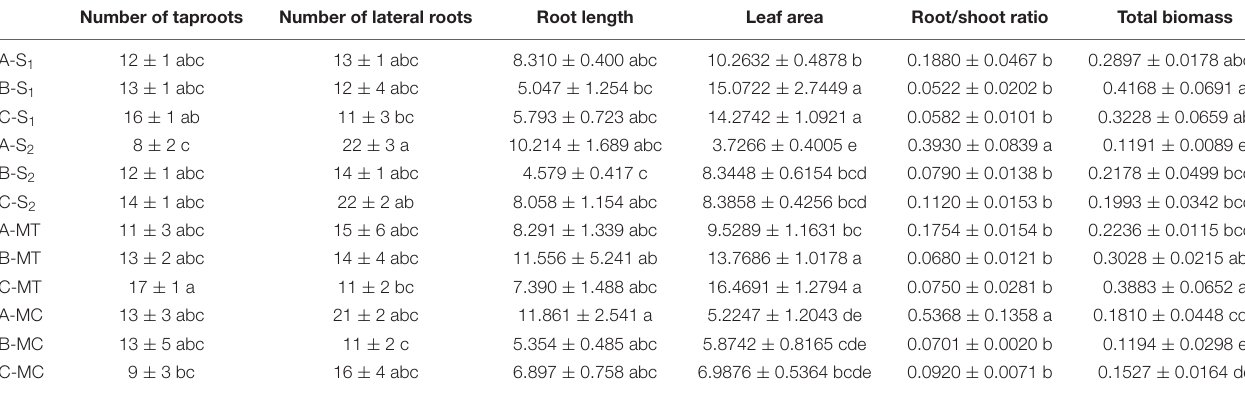
TABLE 2 | Effect of different nitrogen forms and competitive treatments on plant growth under high nitrogen condition. Number of taproots Number of lateral roots Root length Leaf area Root/shoot ratio Total biomass